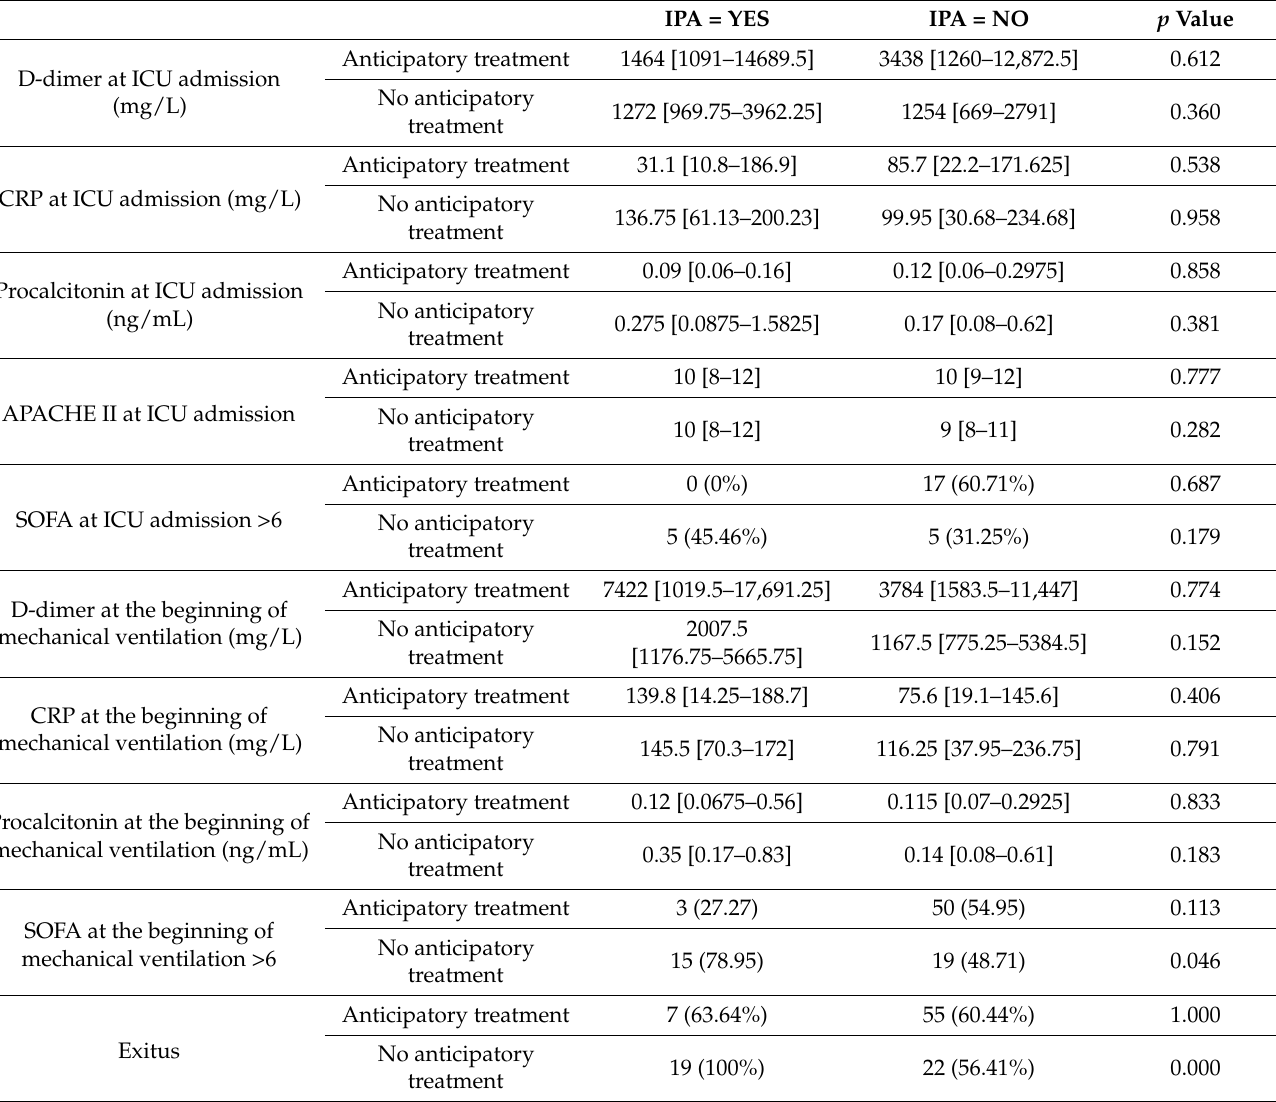
Table 4. Comparative data according to CAPA diagnosis and early antifungal